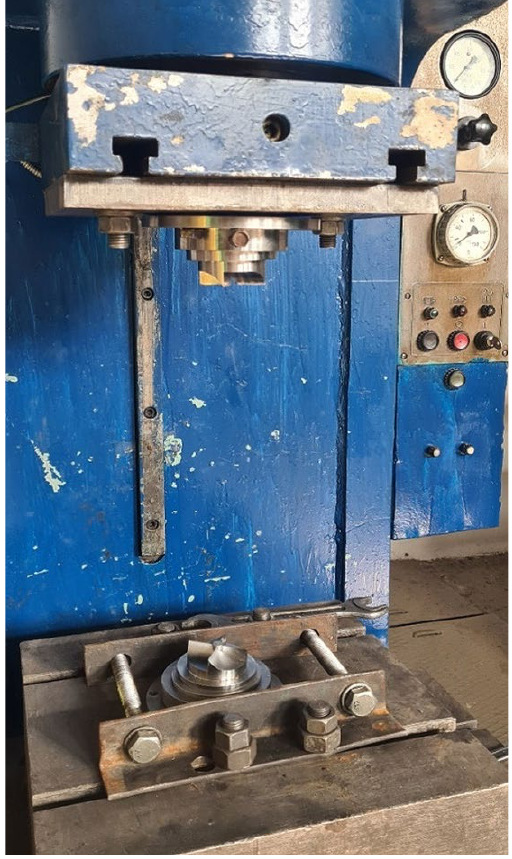
Figure 2. Construction fixed on the